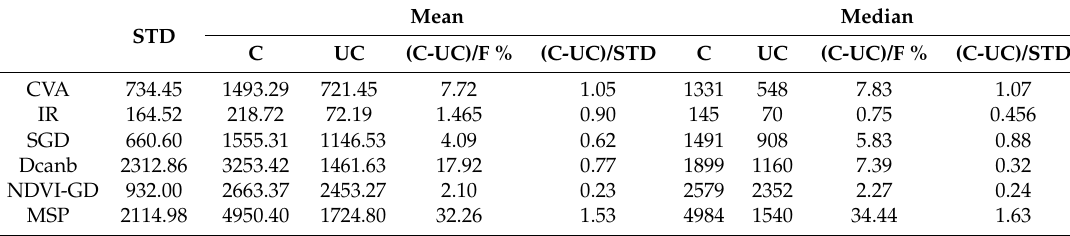
Table 1. The means and medians of the change magnitudes in 2100 changed (C) and 2523 unchanged (UC) ground truth points and the standard deviations (STDs) in these 4623 ground truth points. All change magnitudes have been normalized and multiplied by the factor F = 10,000; CVA: change vector analysis; IR: image ratioing; SGD: spectral gradient-based change detection; Dcanb: distance of Canberra; NDVI-GD: NDVI gradient difference; MSP: multiple shape parameter-based